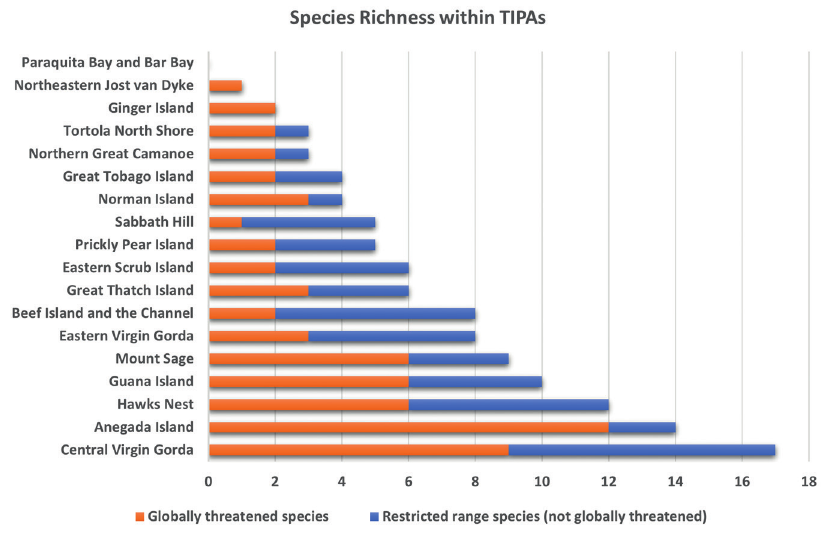
Figure 4. Species richness within the BVI TIPAs network. Data show number of Species of Conserva- tion Concern, comprised of globally threatened species and restricted range species which are not globally threatened, in each TIPA